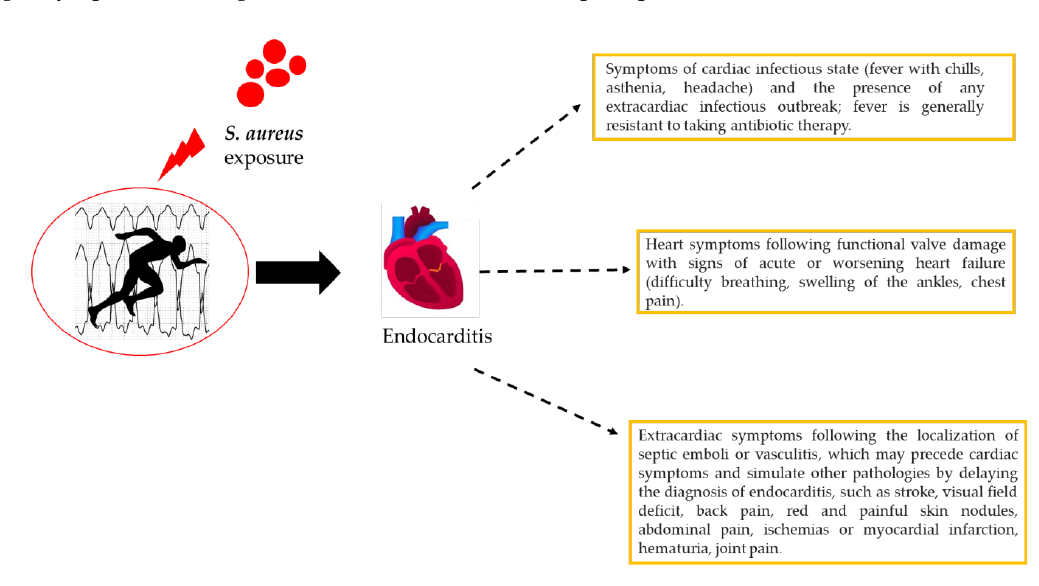
Figure 5. Staphylococcus aureus endocarditis.